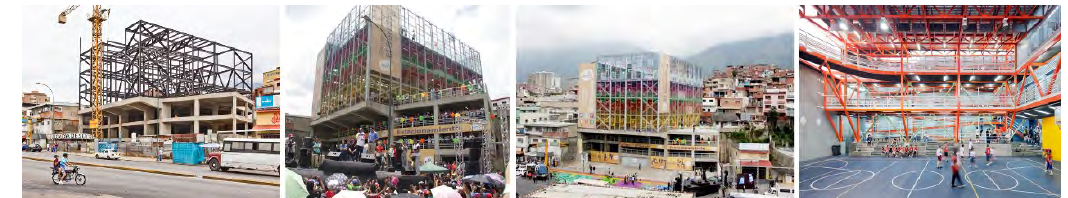
Figure 8. The vertical gym in La Cruz duringconstruction and after implementation. Source: (Brillembourg, & Klumpner, 2011), (Hurley,